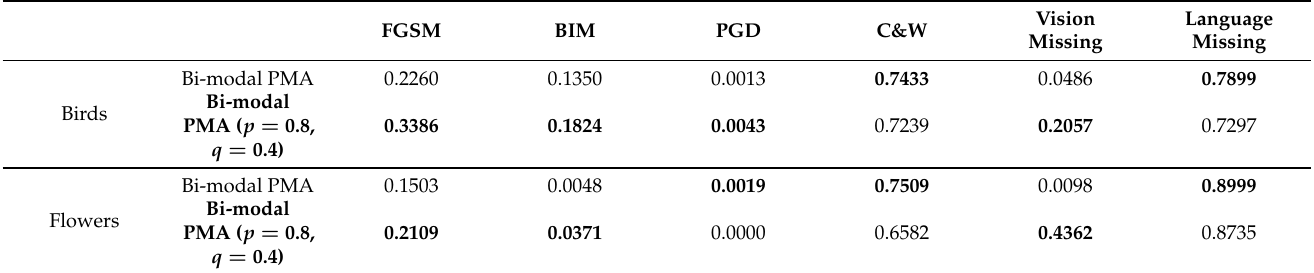
Table 4. Comparison of the accuracy of the Bi-modal PMA method trained by the random modality deactivation method.